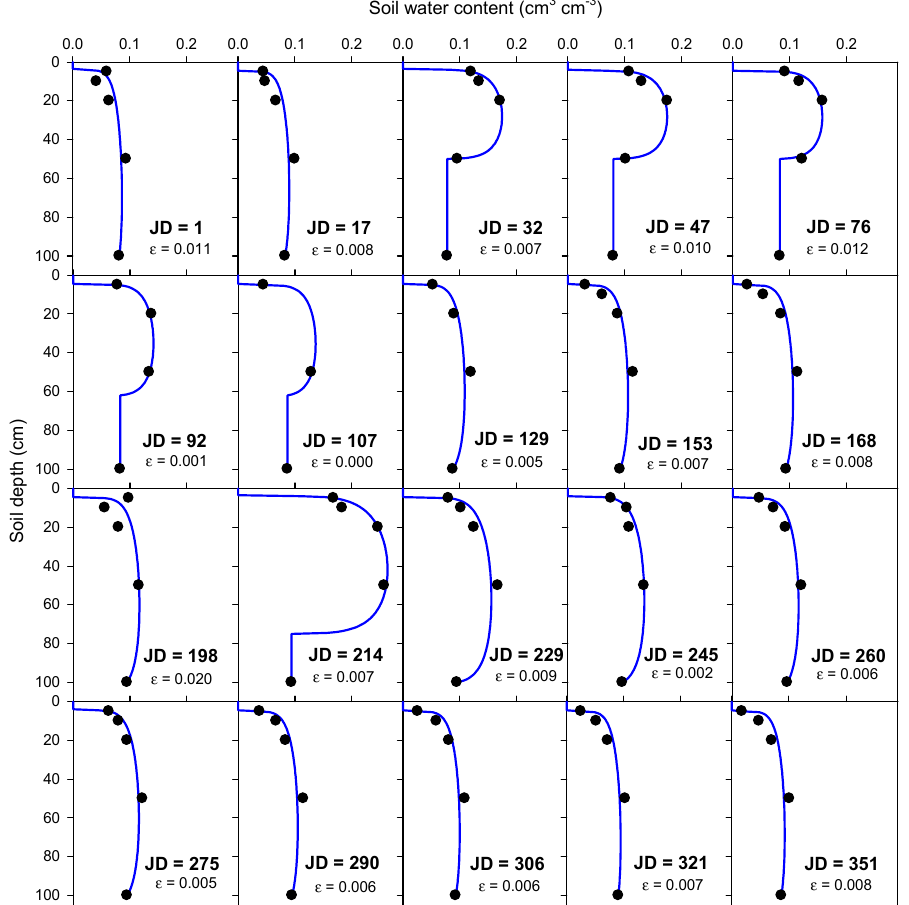
Figure 6. The best fit of Equation (21) (lines) to measured soil moisture data (dots) from SCAN site number 2026 (Walnut Gulch, Arizona) at various dates during 2010. The loam soil parameters, P = 6.6 and h cM = 87 cm, were used for fitting Equation (21). The fitting accuracy is quantified with the mean absolute error, ε (cm 3 cm − 3 ).